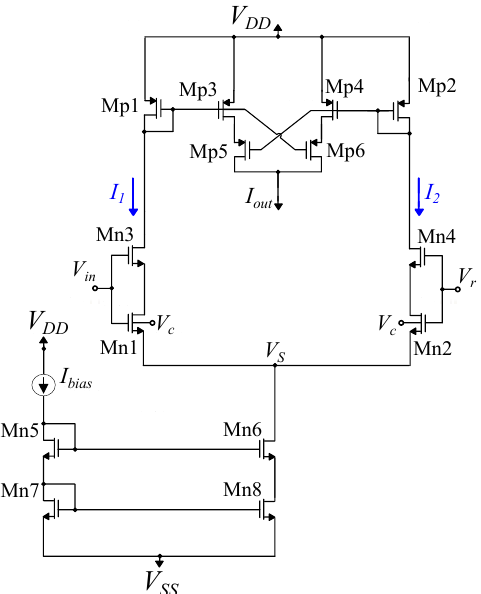
Figure 2. The proposed analog architecture implementing a Gaussian function (bump circuit). V in , V r , V c , and I bias are the input voltage, the voltages controlling the mean value, and the variance and the bias current controlling the height of the Gaussian curve, respectively.